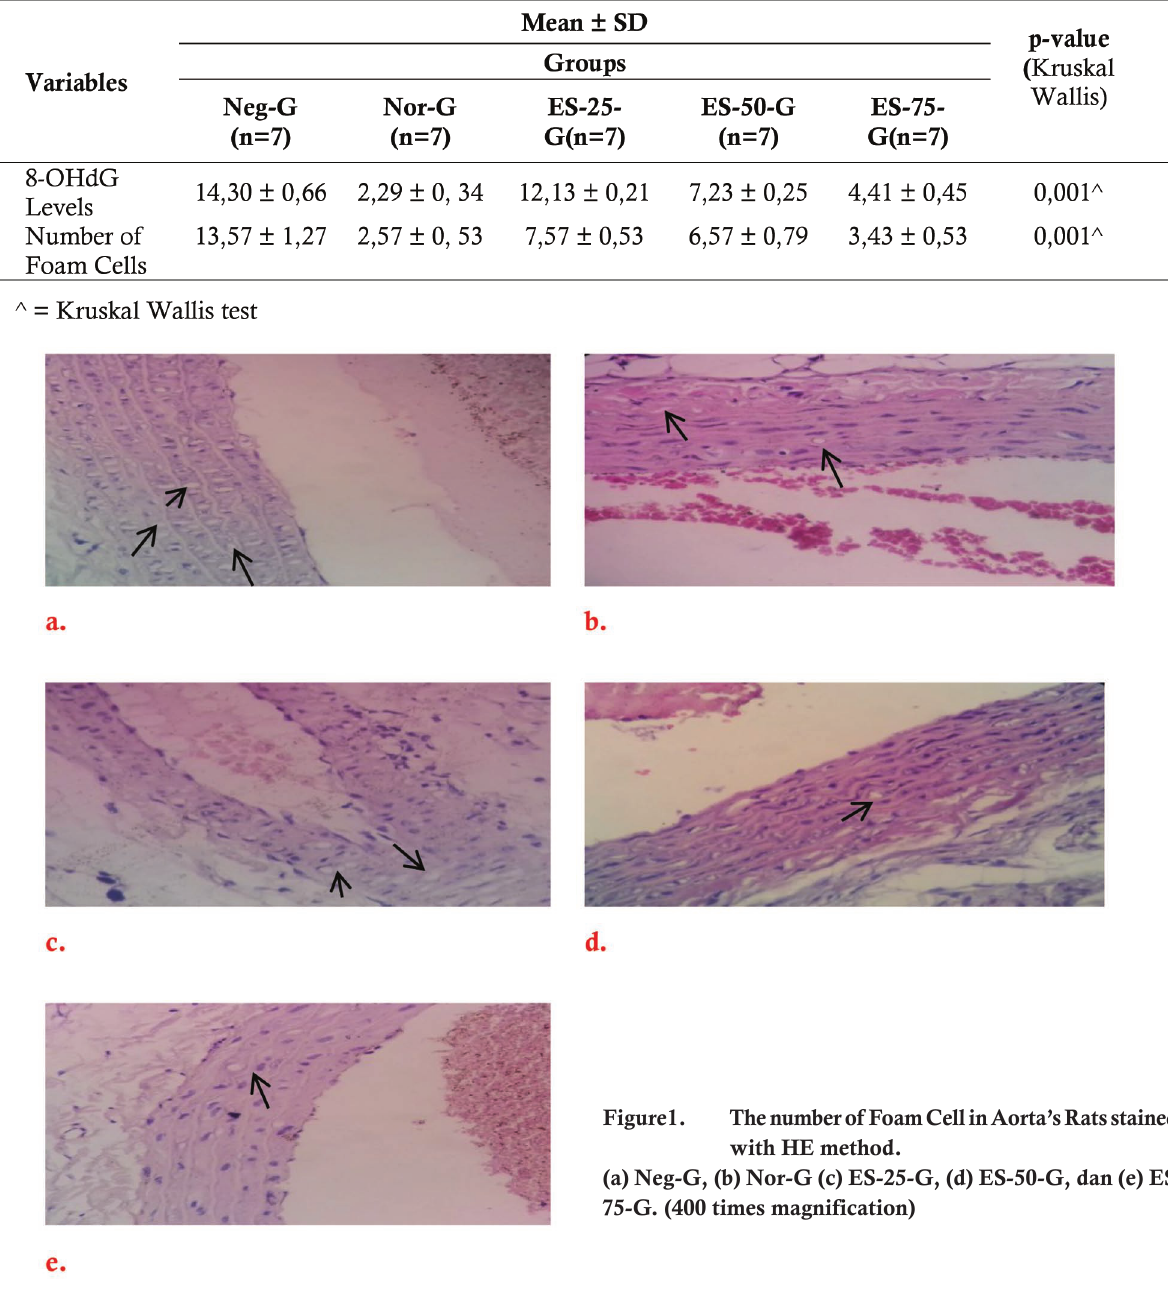
Table 1. Levels of 8-OHdG and Number of Foam Cell